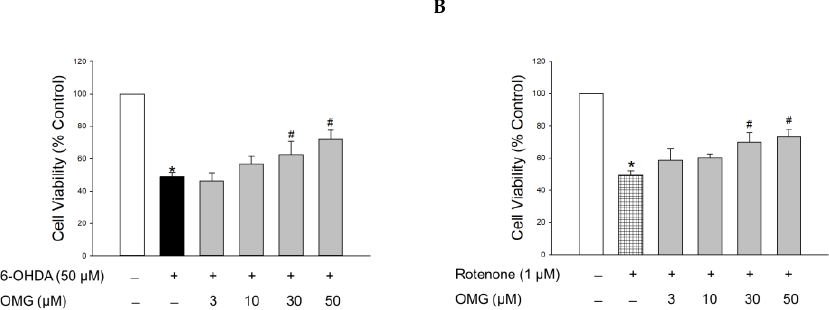
Figure 2. Effects of OMG on 6-OHDA- or rotenone-induced oxidative toxicity in PC12 cells. PC12 cells were pretreated with OMG at the indicated concentrations for 4 h and subsequently exposed to ( A ) 6-OHDA or ( B ) rotenone for an additional 24 h. Cell viability was evaluated by MTT assay, as described in the Materials and Methods section. Data are displayed as the mean ± SEM of three independent experiments. *, p < 0.05 and # , p < 0.05 vs. vehicle-treated control cells and 6-OHDA- or rotenone-treated cells, respectively. OMG, omarigliptin; 6-OHDA, 6-hydroxydopamine.